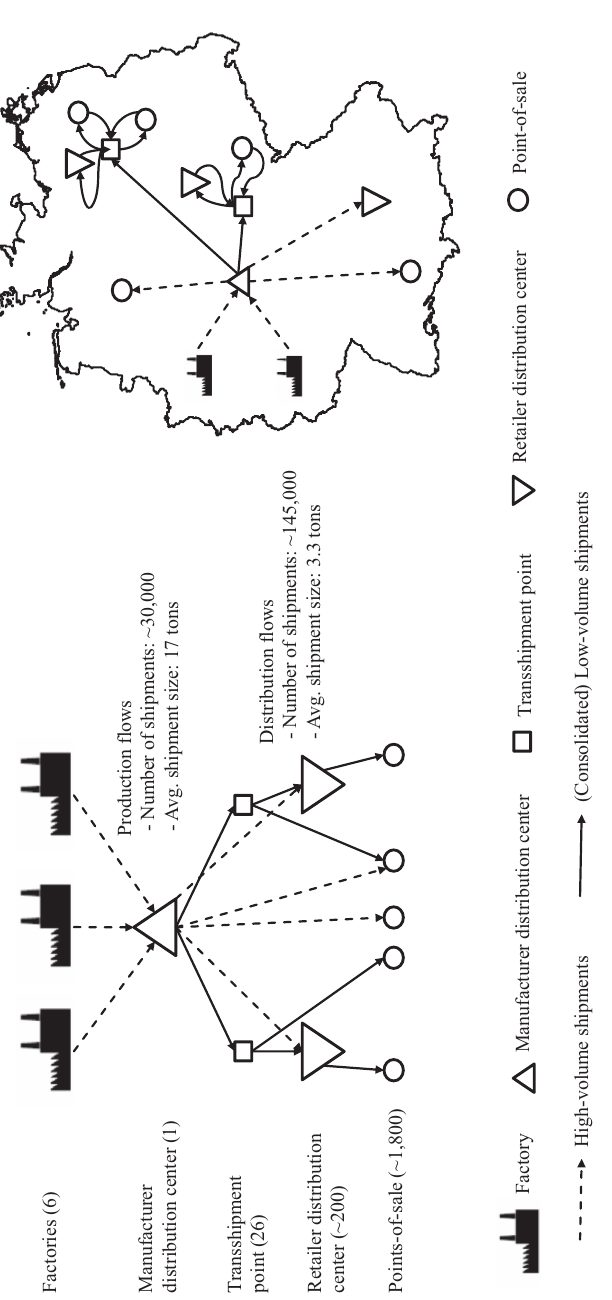
Figure 1. Distribution network of the focal